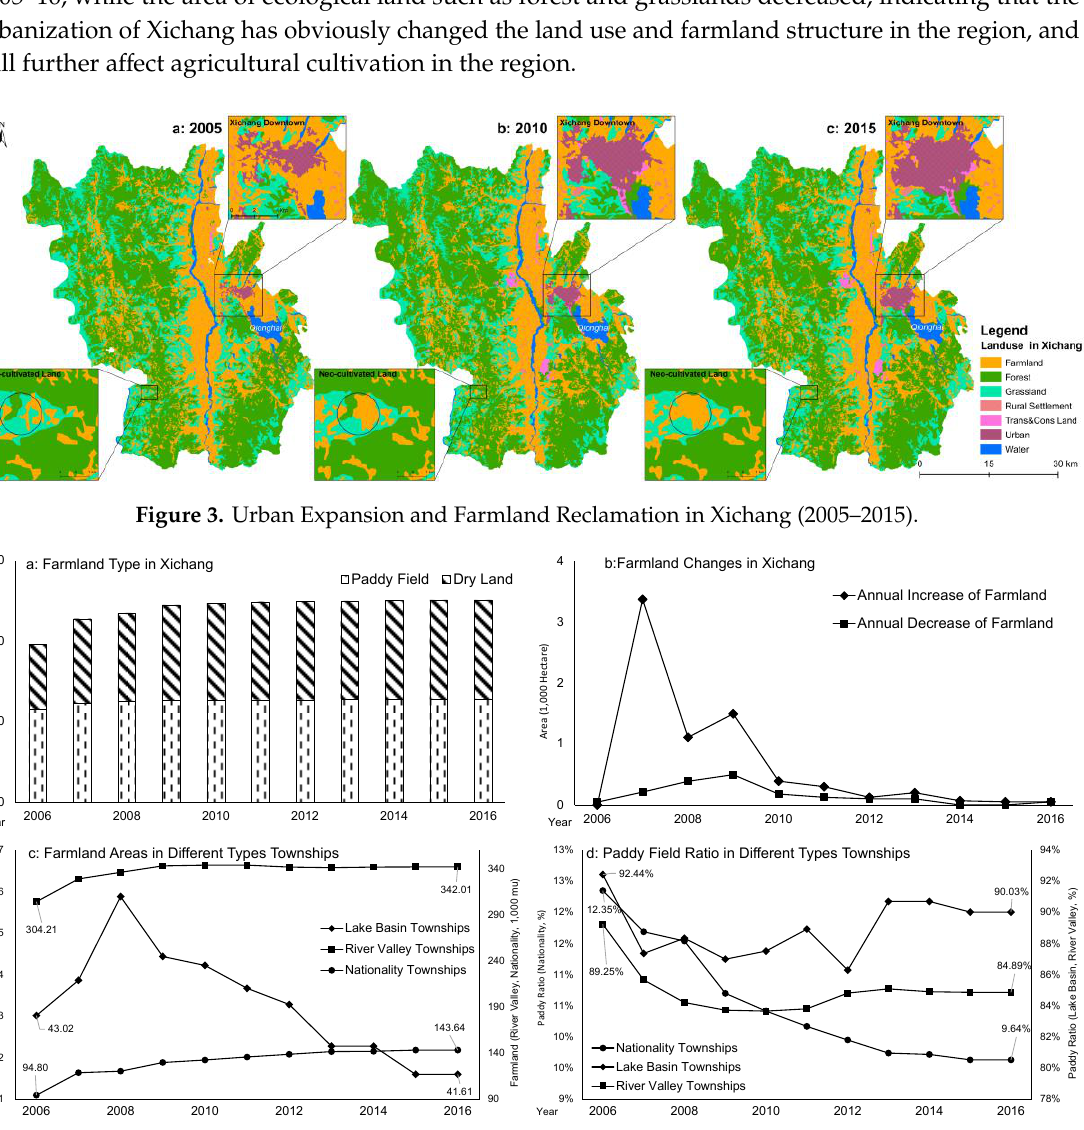
Figure 4. Farmland structure and its changes in Xichang from 2006–16.